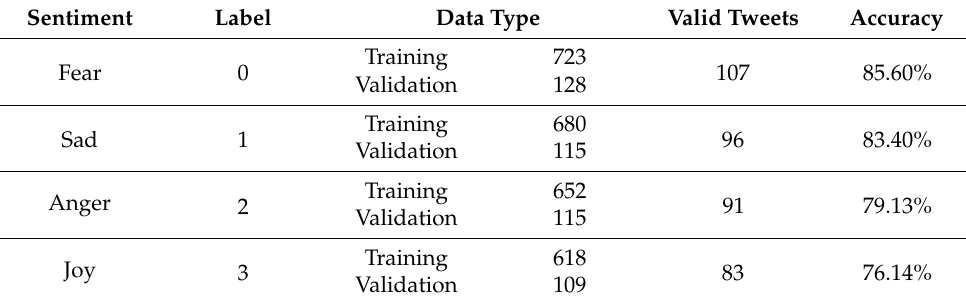
Table 4. Sentiment tweet distribution for model